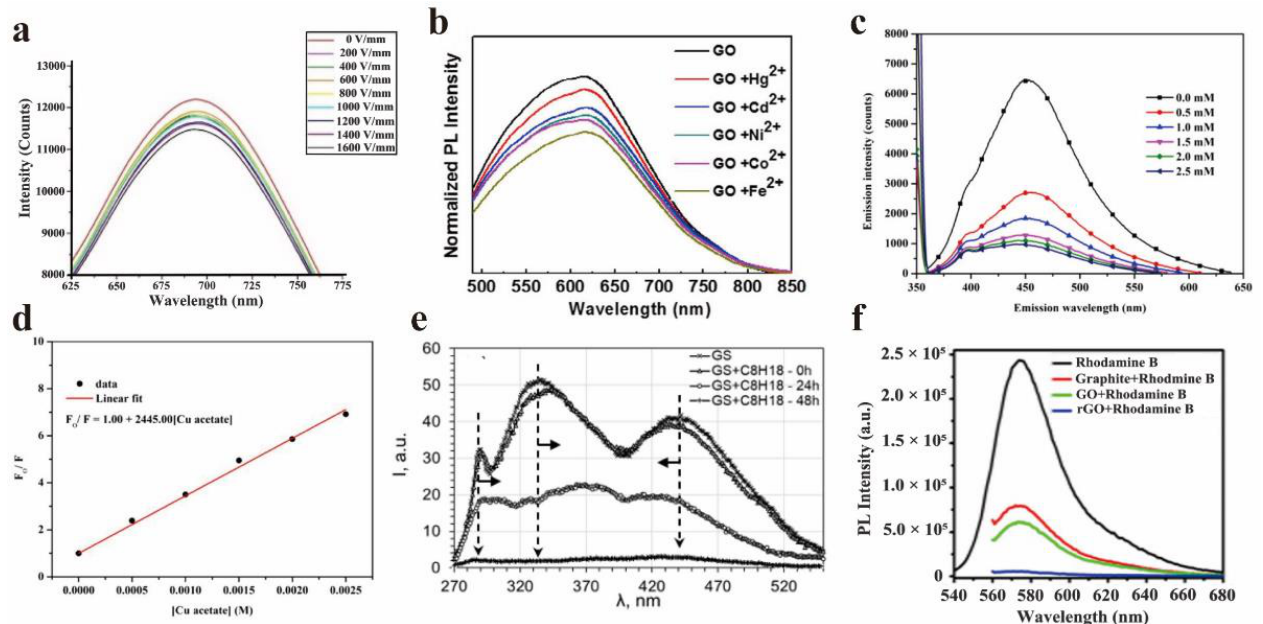
Figure 13. ( a ) PL spectra of GO in GO/PVP films under different electric field conditions. Reprinted with permission from [33]. Copyright 2020, IOP Publishing Ltd. ( b ) PL spectra of GO solution with different metal ions. Reprinted with permission from [74]. Copyright 2015, Elsevier. ( c , d ) The fluorescence spectrum and Stern–Volmer diagram of GQD with different copper acetate concentrations (0~2.5 mM). Reprinted with permission from [75]. Copyright 2021, Taylor & Francis, Web: www.tandfonline.com. ( e ) Effect of saturated hydrocarbon on photoluminescence spectra of GS (excited by 270 nm). Reprinted with permission from [76]. Copyright 2021, Elsevier. ( f ) Rhodamine B dye for graphene, GO, rGO fluorescence quenching PL. Reprinted with permission from [77]. Copyright 2009, American Vacuum Society.